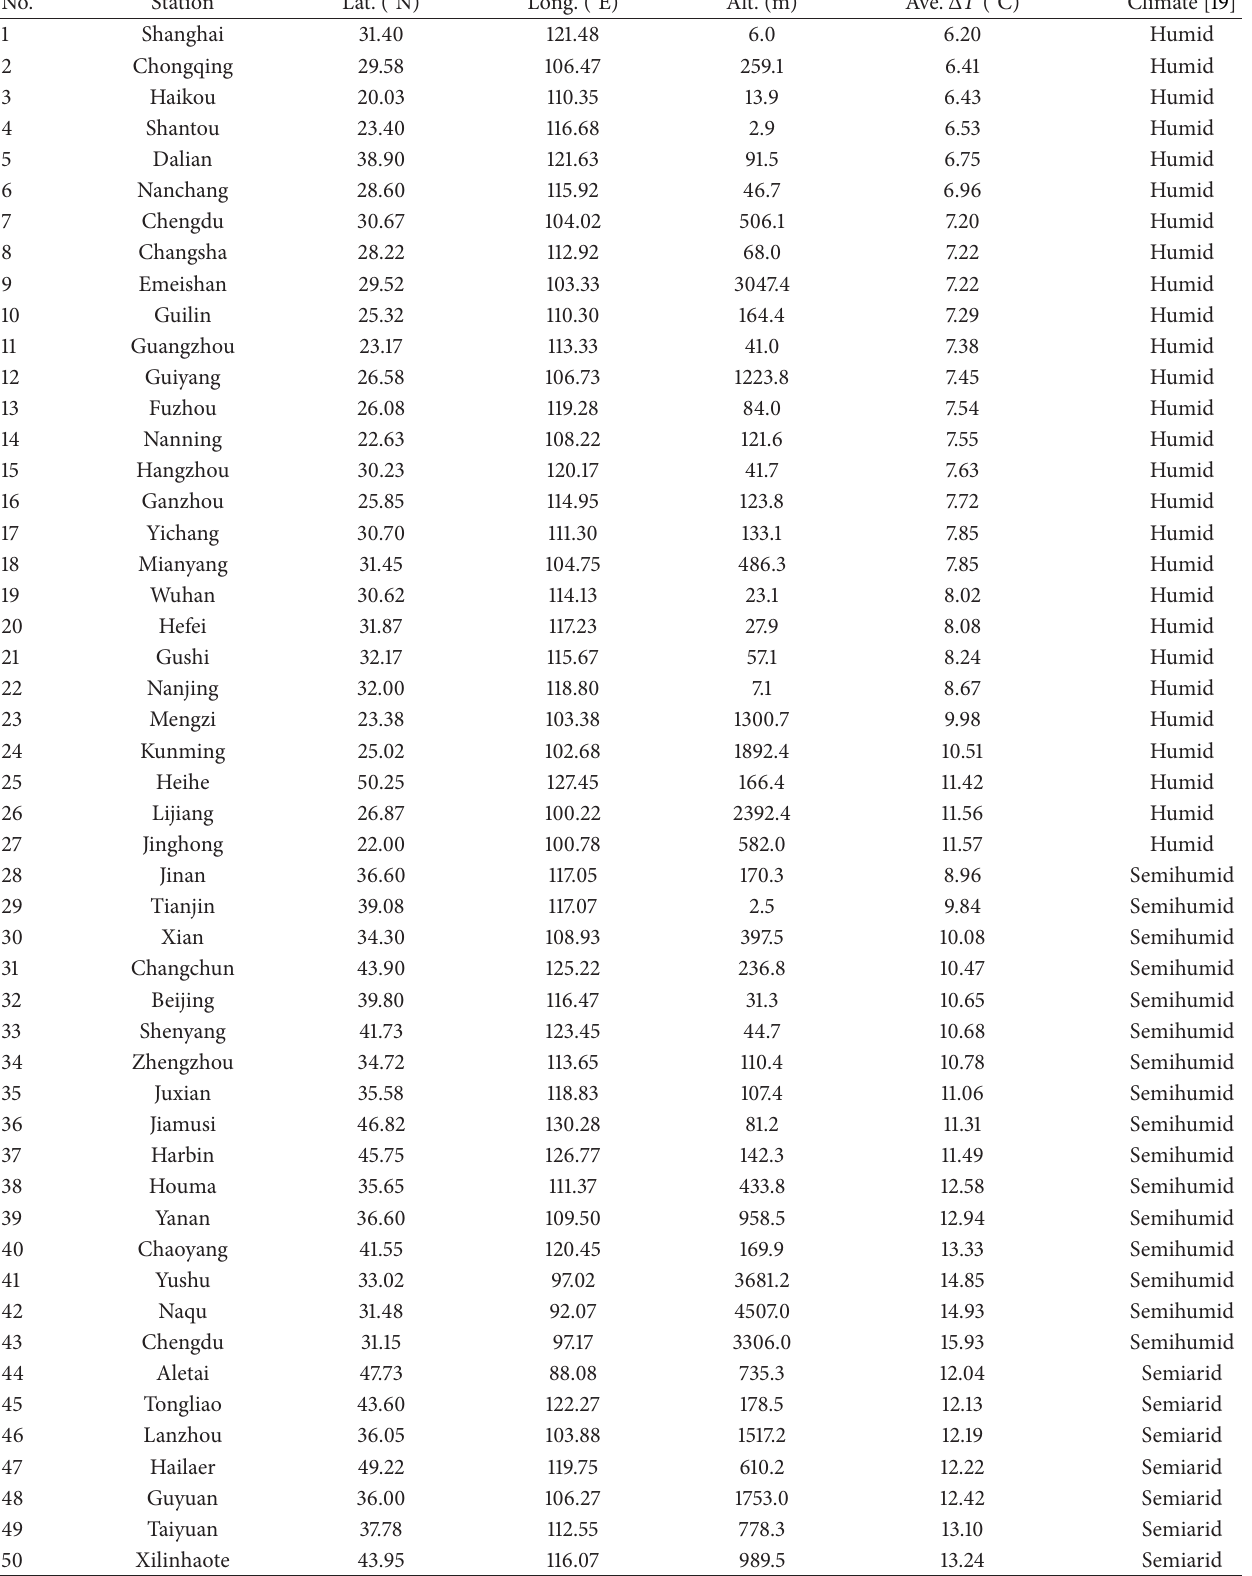
Table 1: Information of the stations used in this